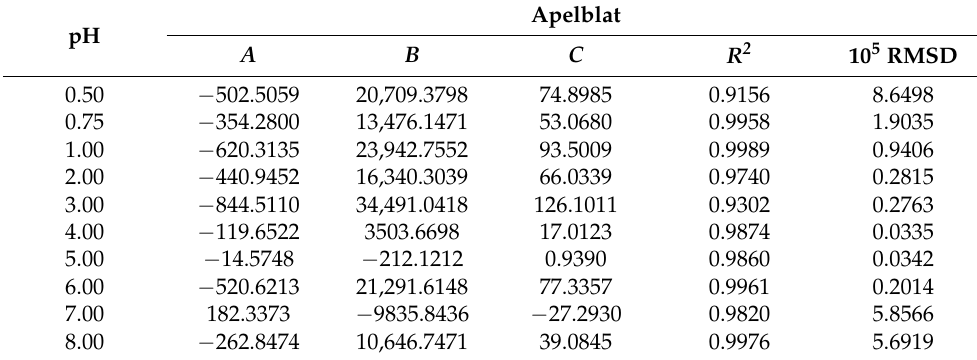
Table 2. Parameters of Apelblat equation estimation for the solubility of 7-ADCA in water.